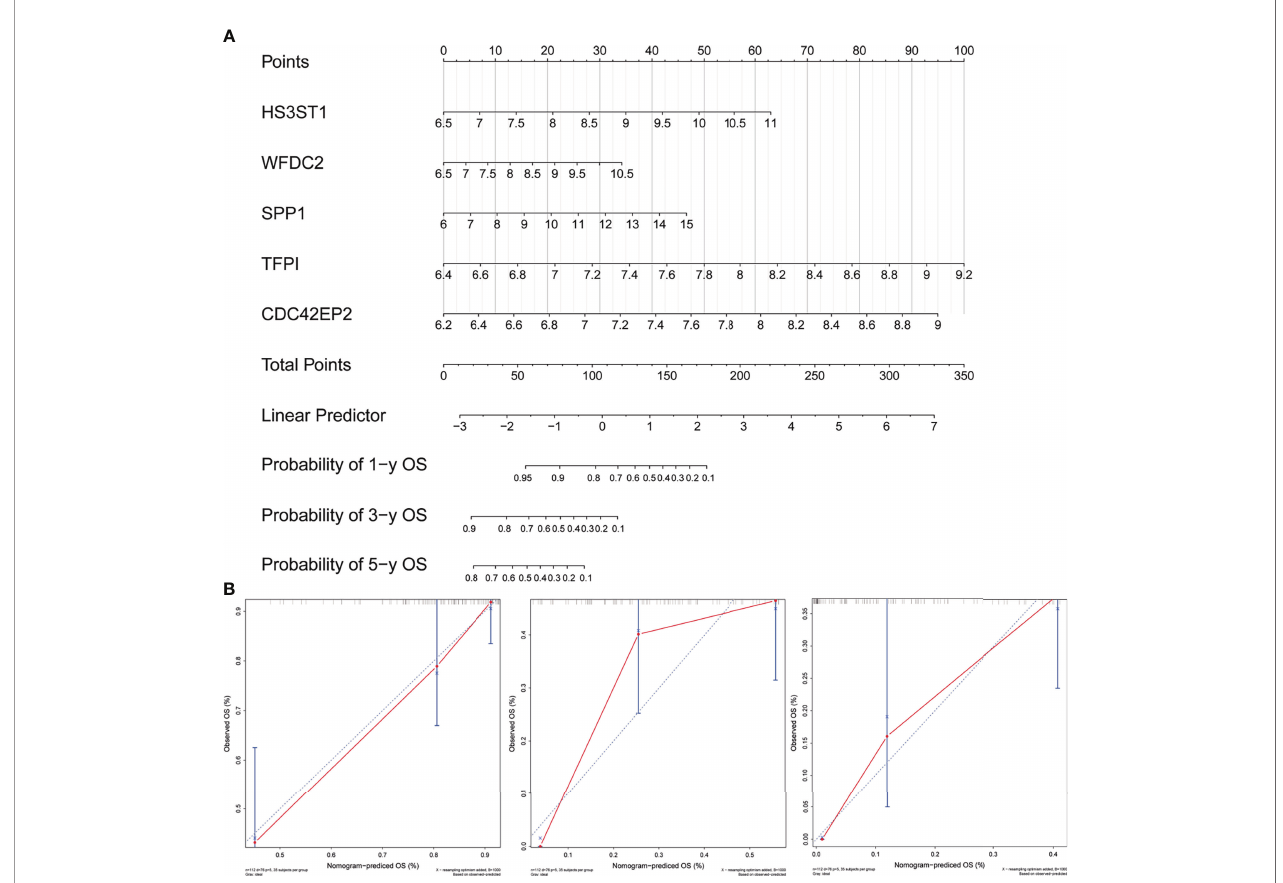
FIGURE 9 | Development and evaluation of the nomogram. (A) A combination of fi ve genes ’ expression was used to construct a nomogram for predicting the 1-, 3- and 5-year overall survival. (B) Calibration curves demonstrate that the nomogram-predicted overall survival probabilities correspond closely to the observed probabilities for 1-, 3- and 5-years in patients with idiopathic pulmonary fi